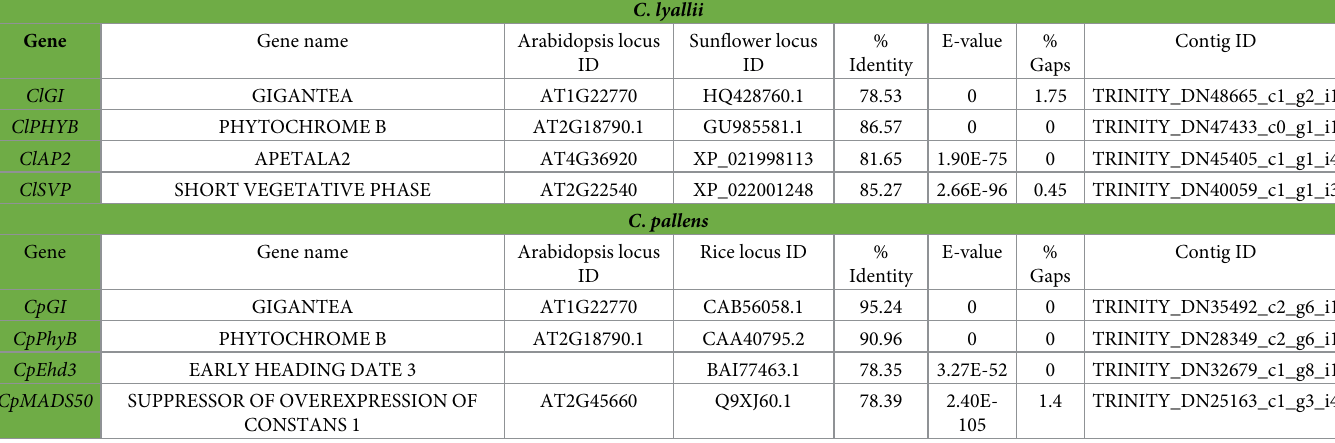
Table 2. Annotation of flowering-related genes selected for RT-qPCR analysis.